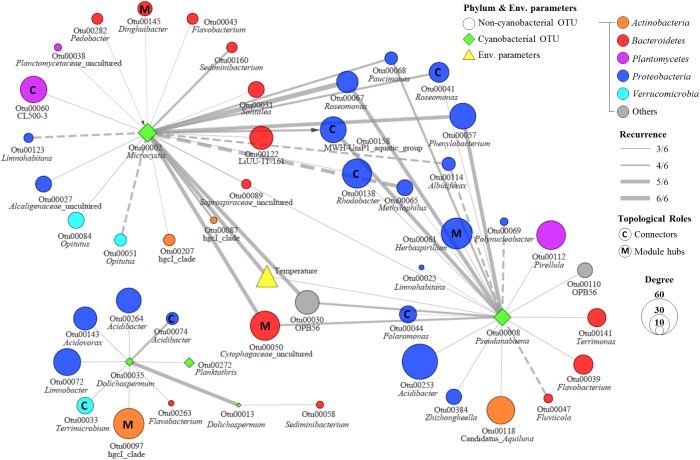
The subnetwork of major cyanobacterial OTUs in the MRAN. Node size represents node degree, solid lines represent positive correlations, dashed lines represent negative correlations, and the arrow represents a delayed correlation.